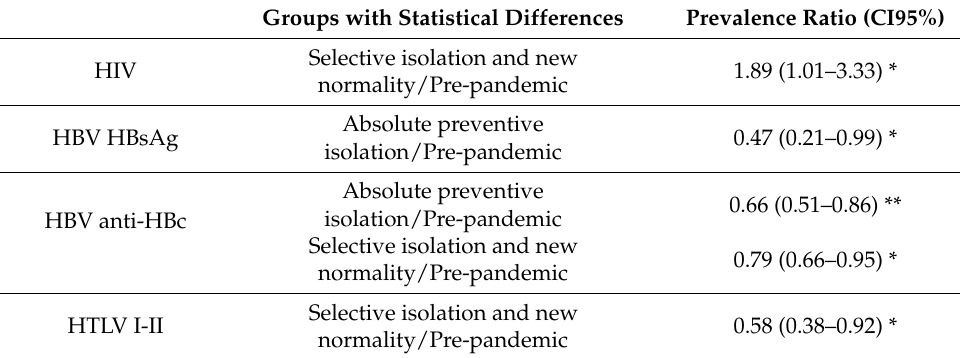
Table 3. Prevalence ratios of viral infections with differences in study groups.